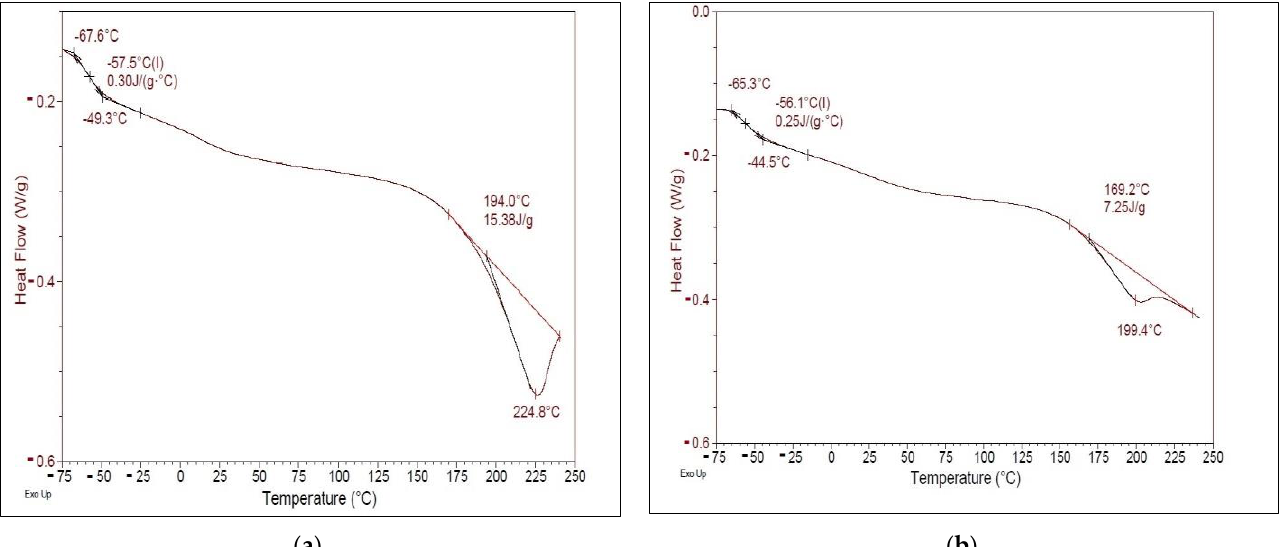
Figure 7. DSC thermograms of starch-based films: ( a ) native corn starch; ( b ) hydrolyzed corn starch under optimal conditions.